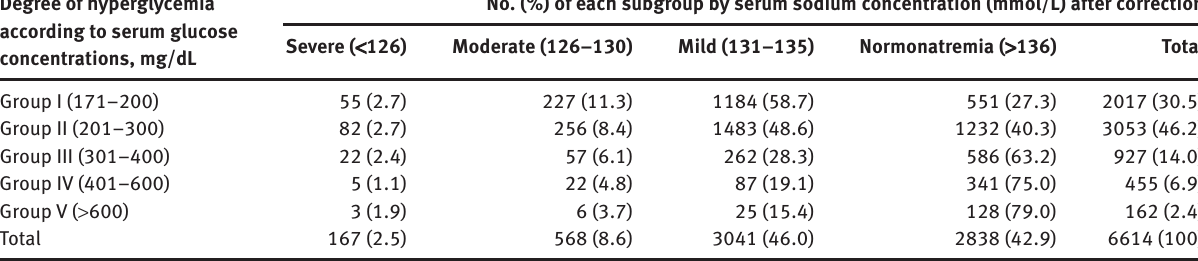
Table 2: Distribution of sodium concentrations after correction. Degree of hyperglycemia according to serum